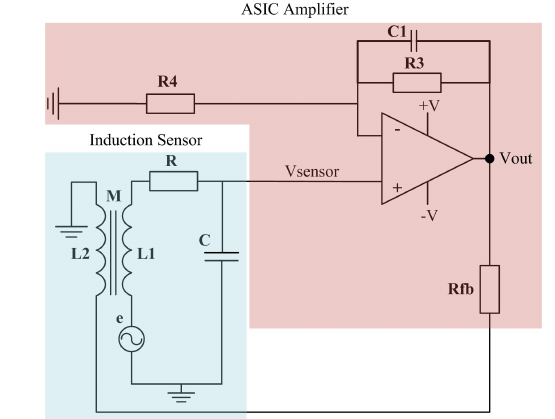
Figure 1. Feedback flux principle.